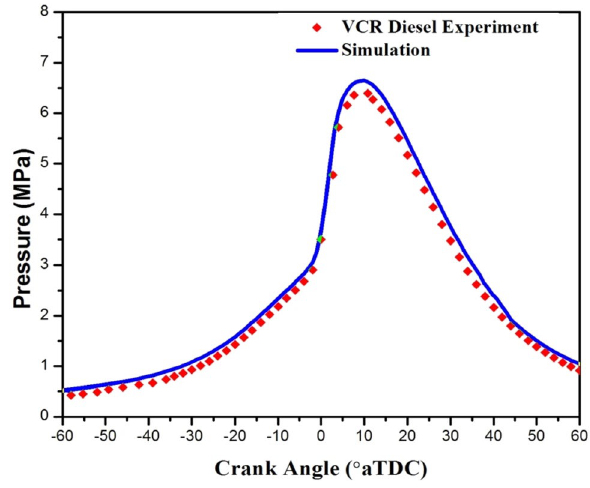
Fig. 2 Validation of pressure versus Crank Angle for VCR diesel